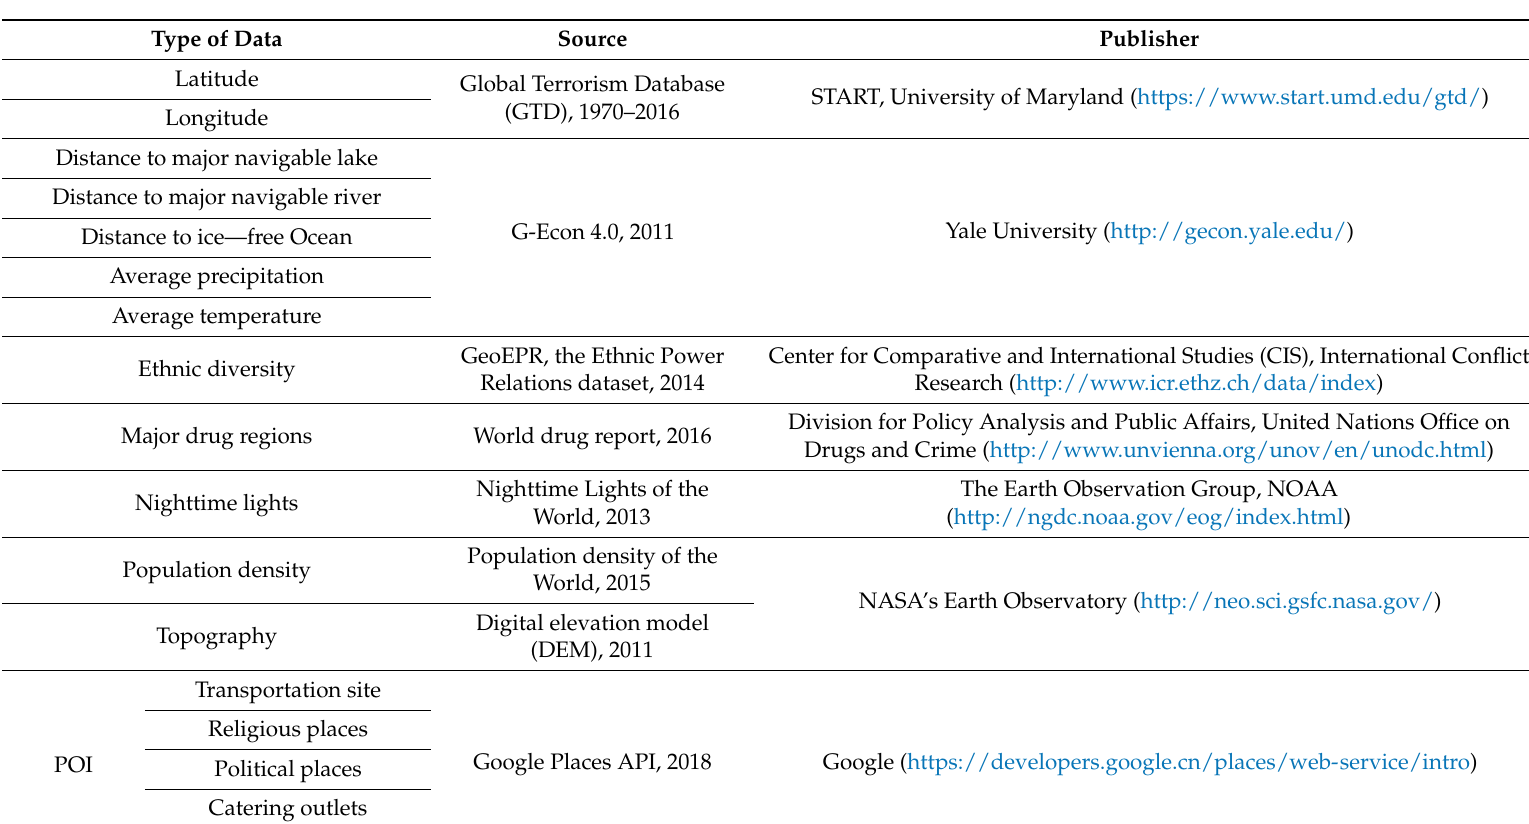
Table 2. Impact factor